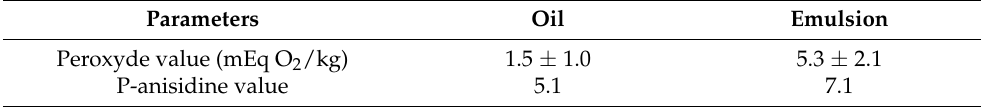
Table 3. Peroxyde and P-anisidine